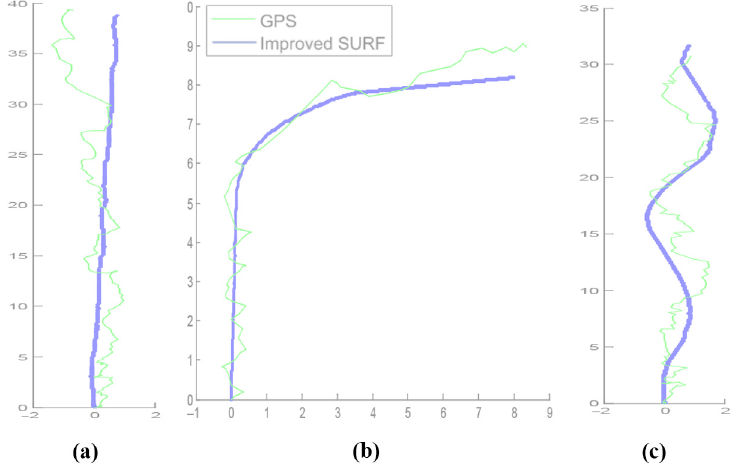
Figure 9 Short-distance